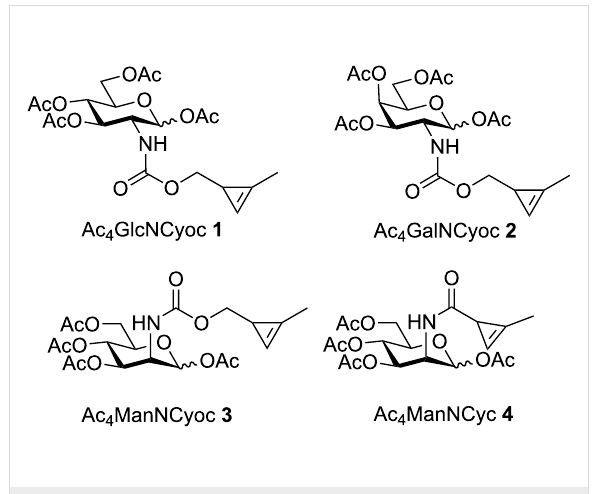
Figure 1: Hexosamine derivatives with cyclopropene tags. Cyoc = (2-methylcycloprop-2-en-1-yl)methoxycarbonyl, Cyc = 2-methylcyclo-